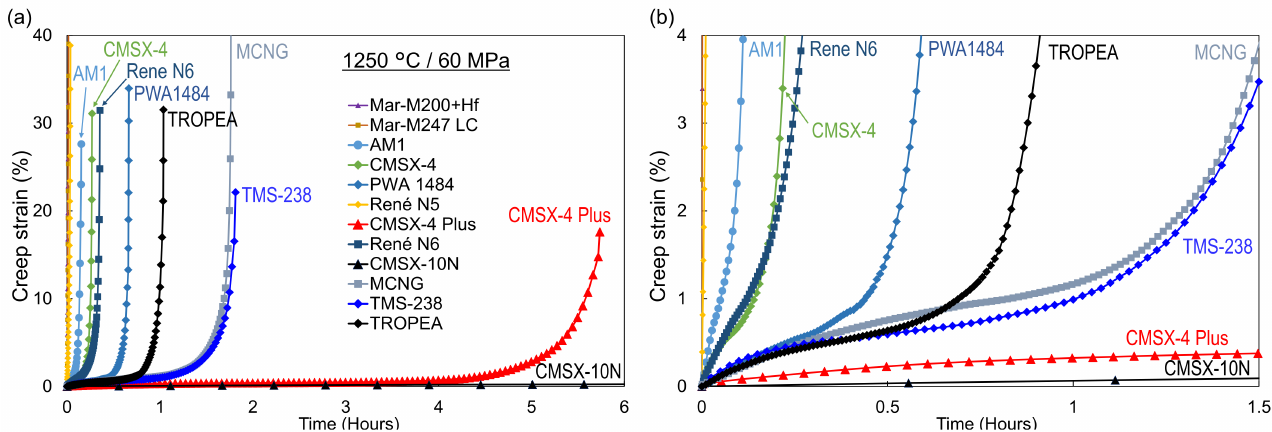
Figure 2. Result of creep tests on SX superalloys at 1250 ◦ C/60 MPa. Scale of ( a ) is enlarged in ( b ) to show difference in primary creep stage. Note that CMSX-10N creep test has been interrupted after 31 h and 0.79% creep